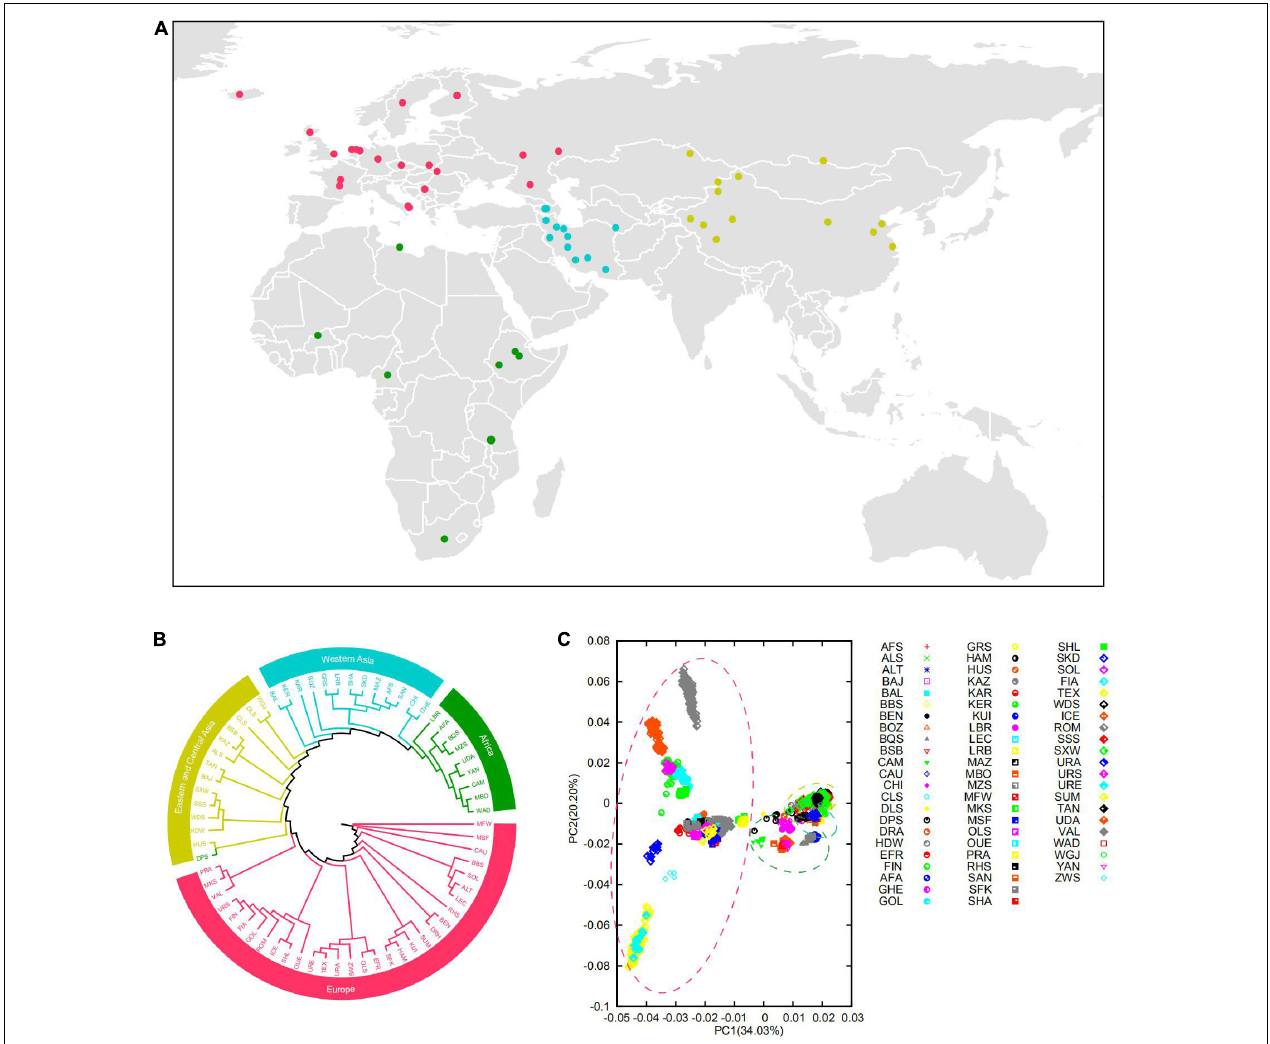
FIGURE 1 | (A) Geographic origin of the domestic sheep populations studied. The domestic sheep populations are color coded according to geographical origin. (B) Neighbor-joining clustering of the sheep populations based on the Reynolds’ distances. (C) Principal component analysis (PCA) of the 67 domestic sheep populations. The circle of yellow, blue, green, and red represent Eastern-Central Asian, Western Asian, African, and European populations,